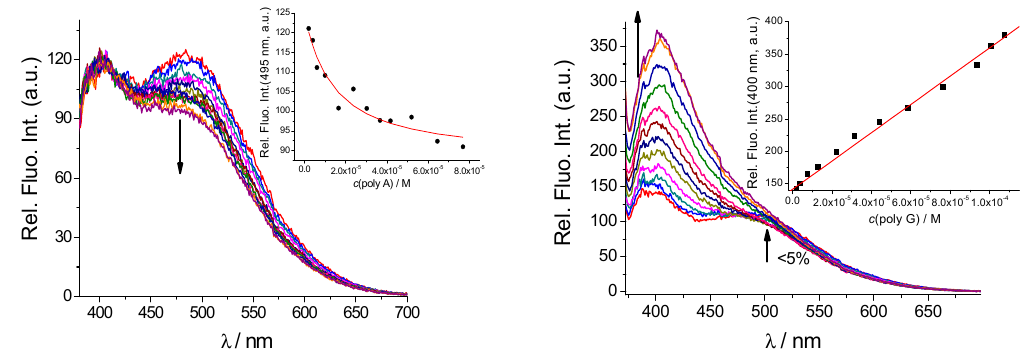
Figure 6. Fluorimetric titration of qAN1-pyr2 ( c = 1 × 10 − 6 M; λ exc = 350 nm) with: ( Left ): poly A, Inset: emission change at 495 nm; ( Right ): poly G, Inset: emission change at 408 nm. Performed in sodium cacodylate buffer (pH 7, I = 0.05 M).